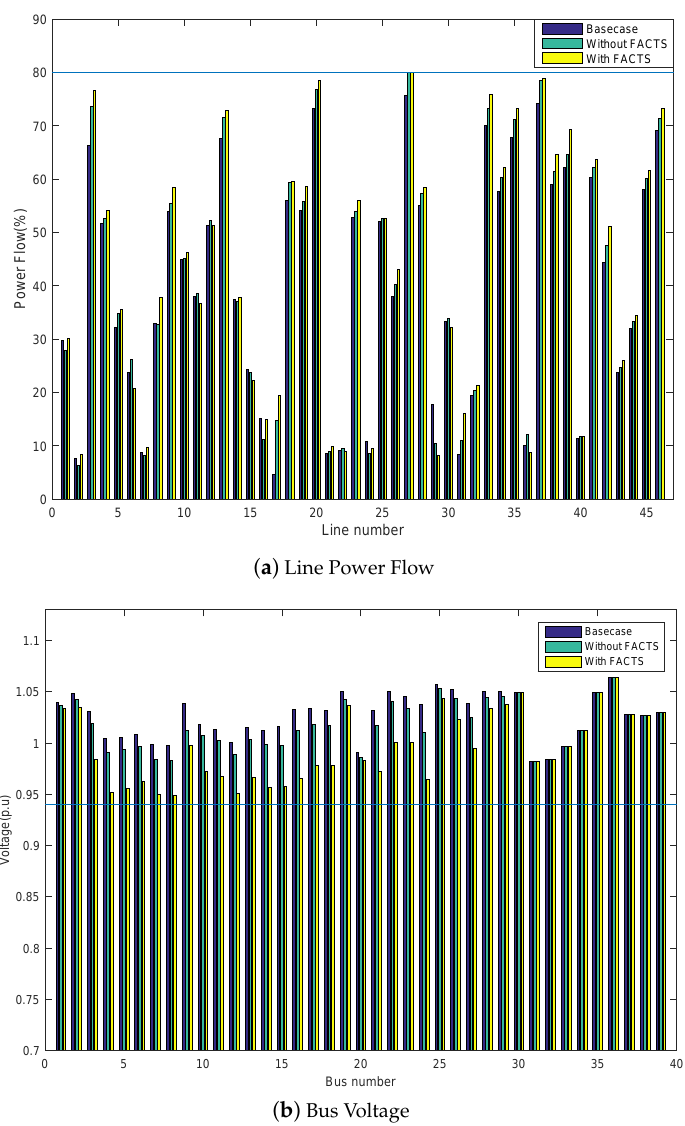
Figure 7. Line power flow and bus voltage of IEEE 39 bus system.